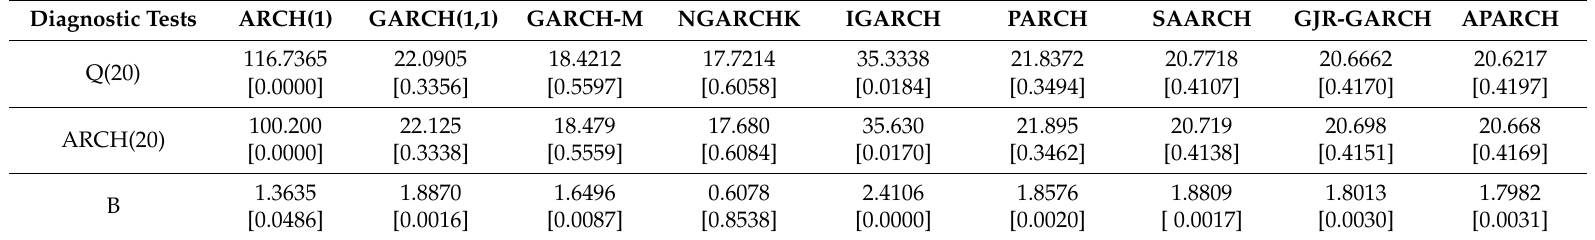
Table A3. Models’ diagnostic tests for SREC prices. Ljung–Box Q, ARCH, and Bartlett test results are